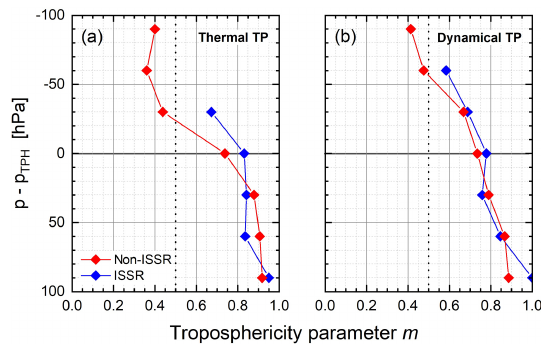
Figure 11. Vertical distribution of the troposphericity parameter m for ISSR and non-ISSR air masses with respect to the thermal (a) and dynamical (b)